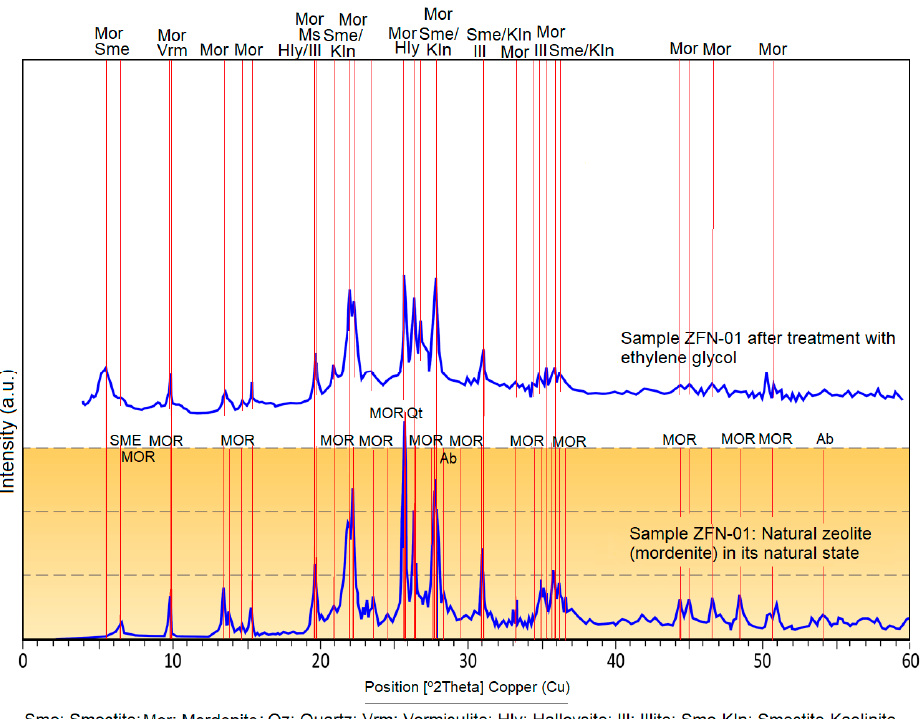
Figure 7. X-ray diffraction patterns of mordenite accompanied by bentonite clay minerals before and after ethylene glycol treatment.